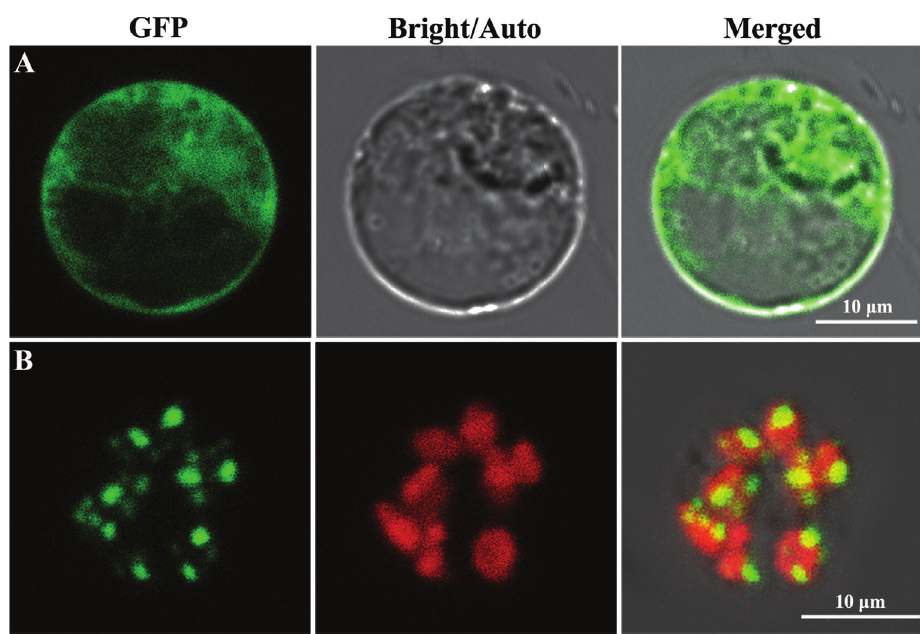
Figure 7 - Subcellular location of YSS2. (A) Free GFP signals in rice protoplasts. (B) Transient expression of YSS2-GFP fusion proteins in rice proto- plasts. GFP: GFP signals of free GFP and YSS2; Bright: bright field; Auto: chlorophyll autofluorescence; Merged: merged